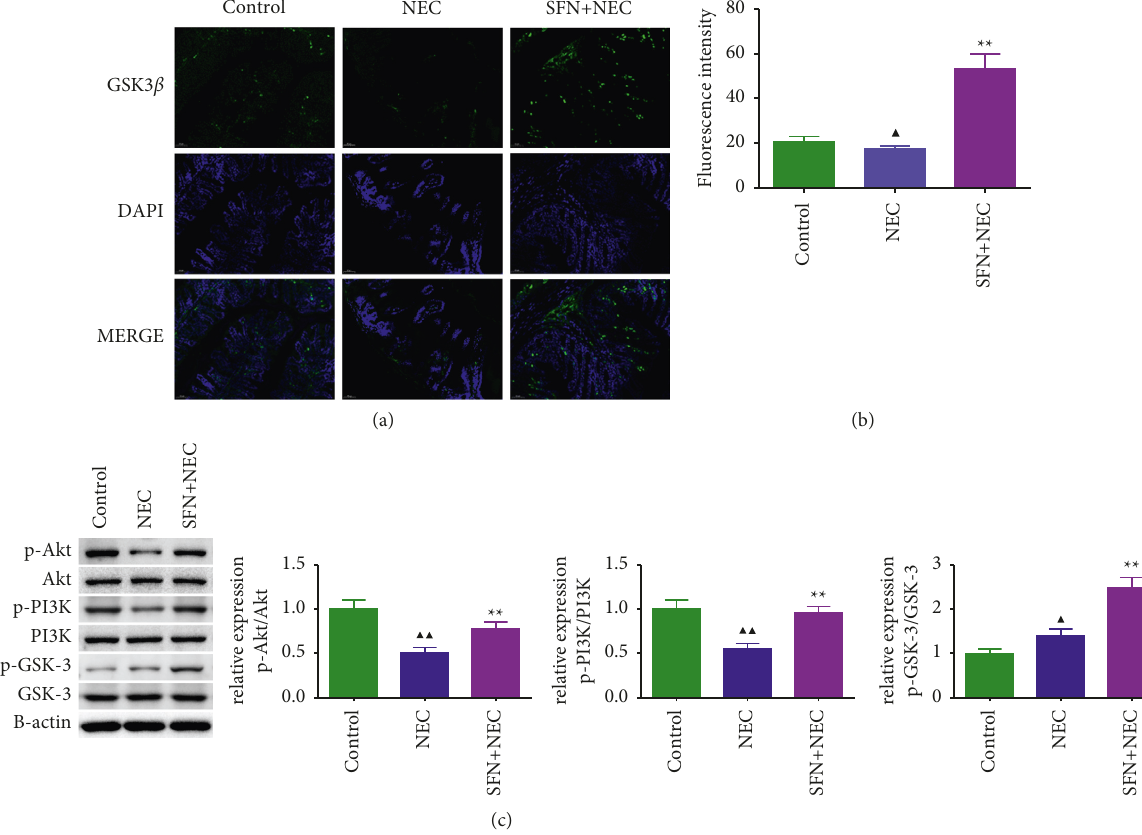
Figure 5: Expression levels of PI3K/Akt/GSK-3 β pathway-related proteins in intestinal tissue of NEC mice. Immunofluorescence staining results of GSK-3 β (a) and fluorescence intensity (b) in intestinal tissues of mice in each group, n � 6, and expression of PI3K/Akt/GSK-3 β pathway-related proteins in intestinal tissue of mice, n � 3. NEC, necrotizing enterocolitis; SFN, sulforaphane. Compared with the control group, ▲ P < 0 . 05, ▲▲ P < 0 . 01; compared with the NEC group, ★ P < 0 . 05, ★★ P < 0 . 01. Data represent the mean ±